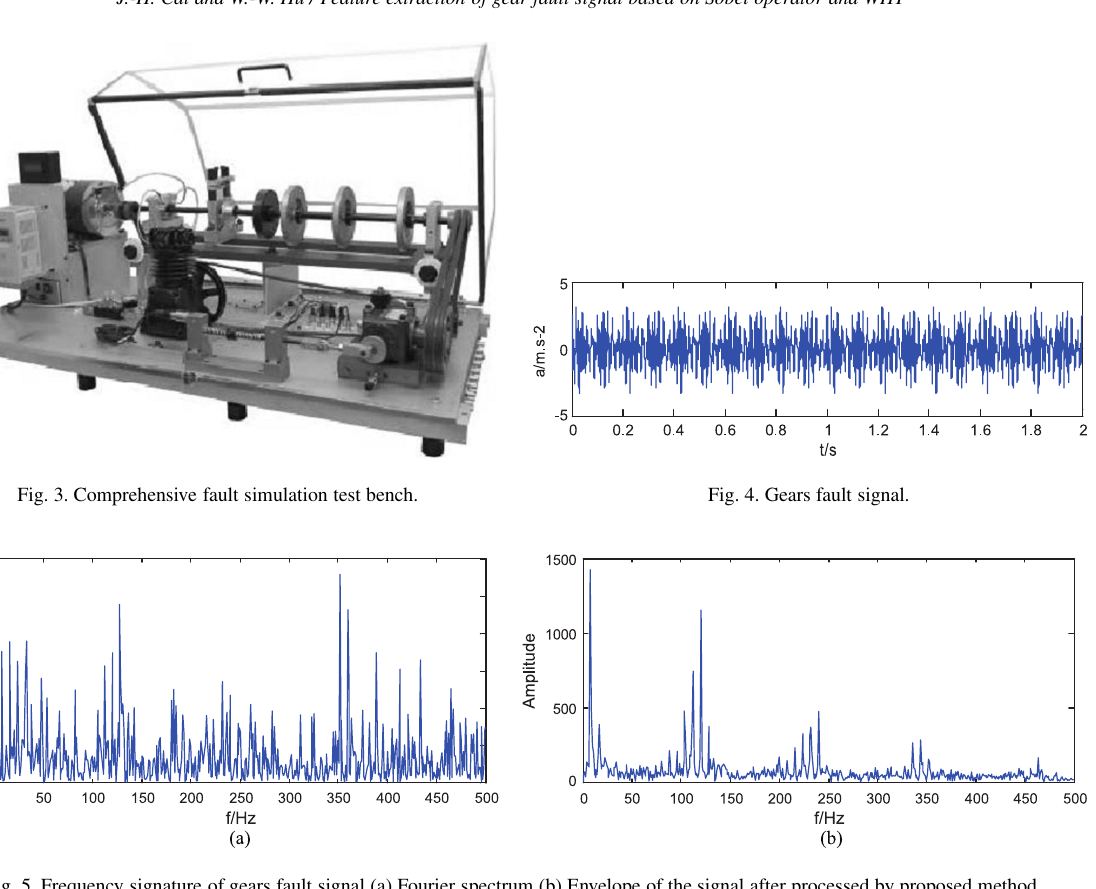
Fig. 5. Frequency signature of gears fault signal (a) Fourier spectrum (b) Envelope of the signal after processed by proposed method. parameters space ( ρ , θ ).From the bottom picture of Figs 2(a) and (b), peaks of kinds of frequency